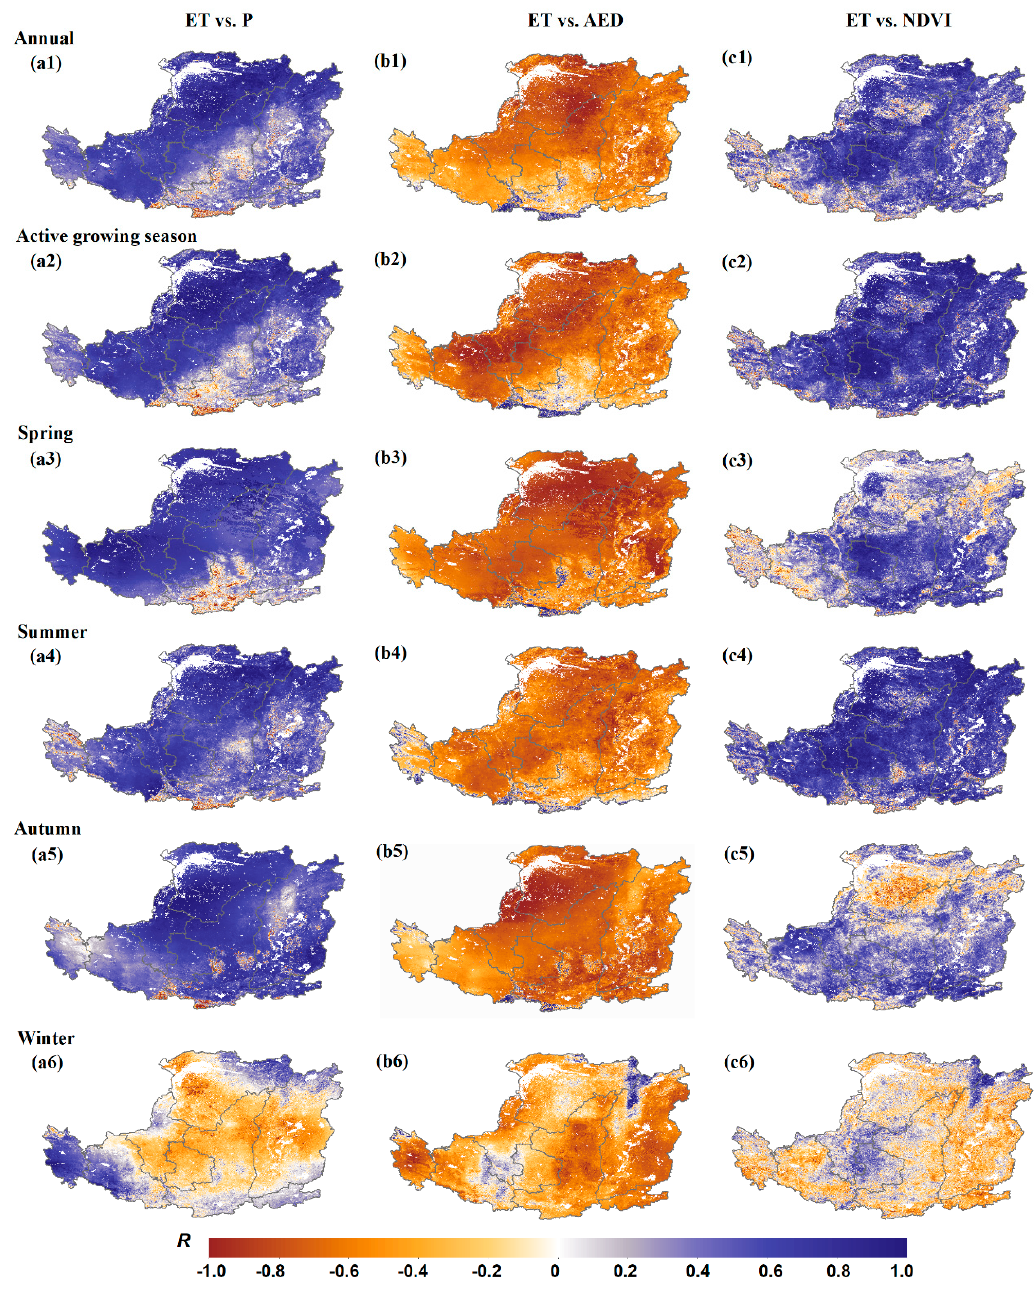
Figure 7. Spatial distributions of correlation coefficients ( R ) between ( a ) precipitation ( P ), ( b ) AED, ( c ) NDVI, and ET during 2000–2014 at the timescales of (1) annual, (2) active growing season, (3) spring, (4) summer, (5) autumn, and (6) winter across the entire